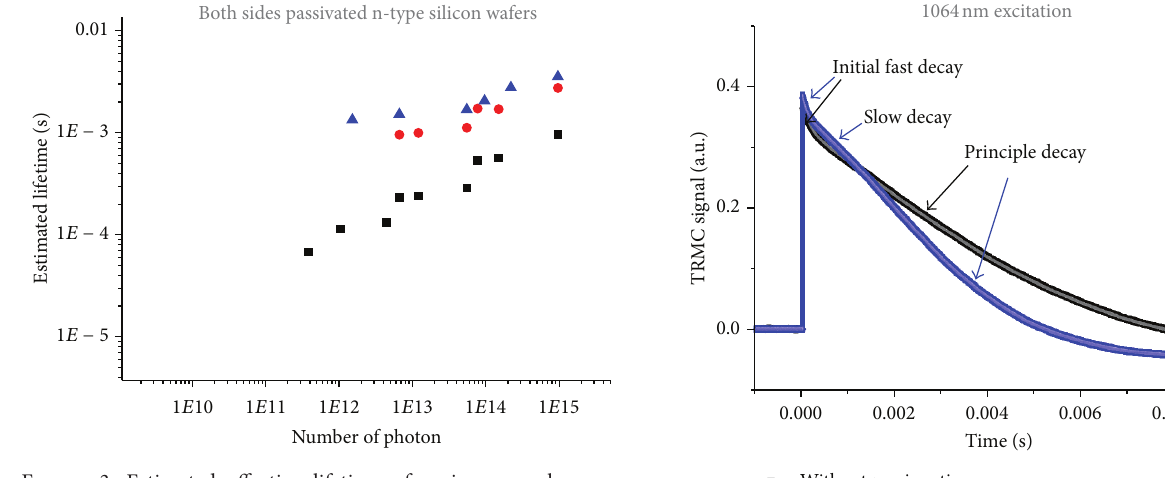
Figure 3: Estimated effective lifetime of various samples as a function of number of photon.